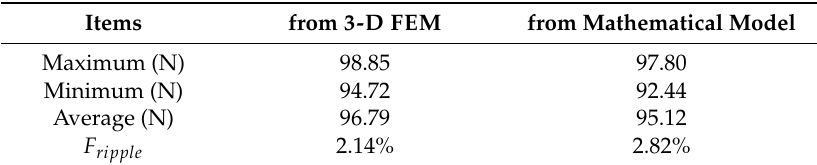
Table 8. Characteristic of thrust force based on different methods.